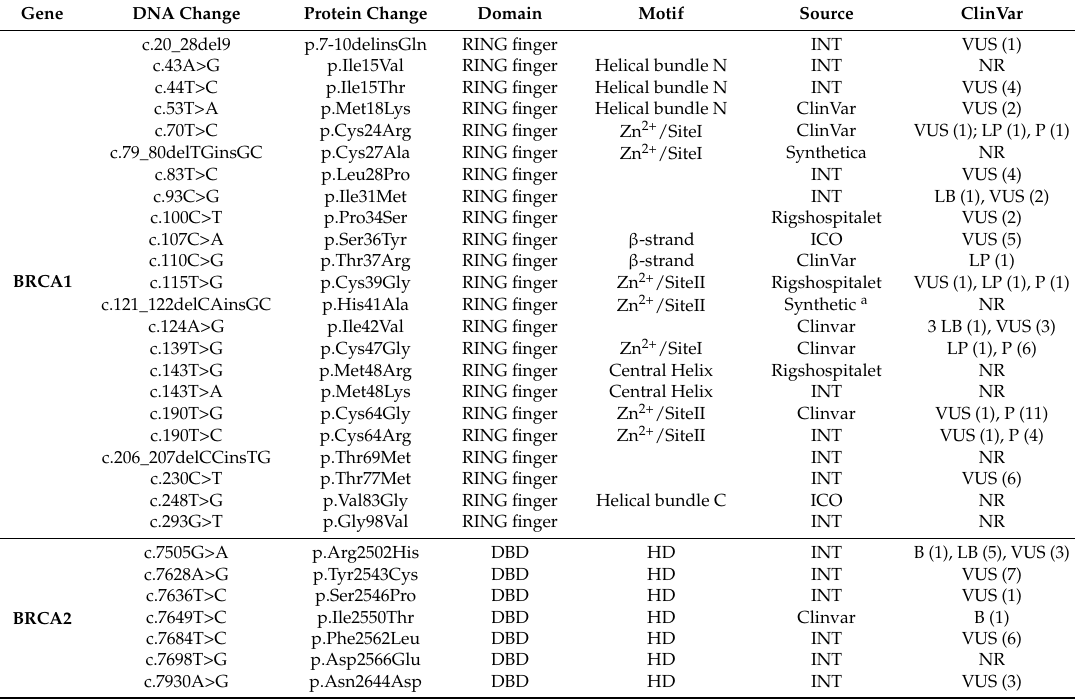
Table 2. List of selected BRCA1 and BRCA2